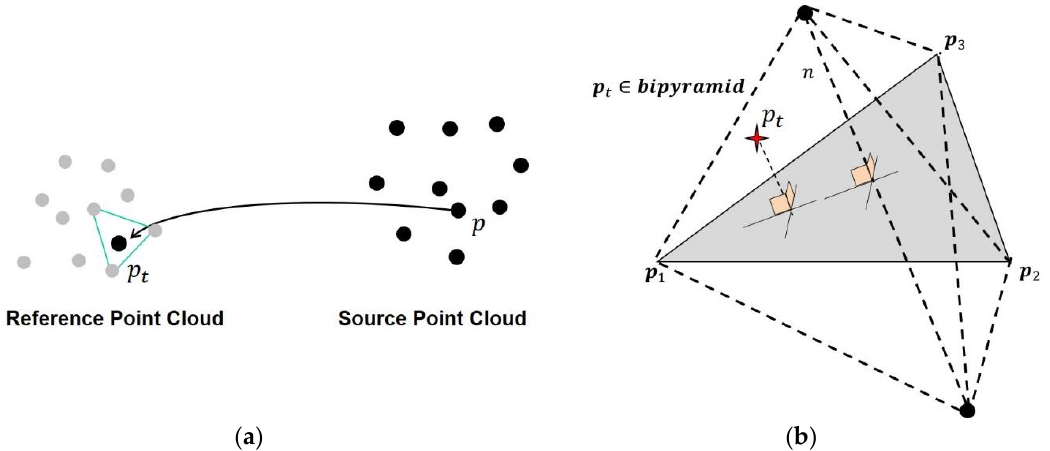
Figure 11. ( a ) Transformation from the source to the reference point cloud, and ( b ) conditions to accept the point-to-patch correspondence between the two point clouds.